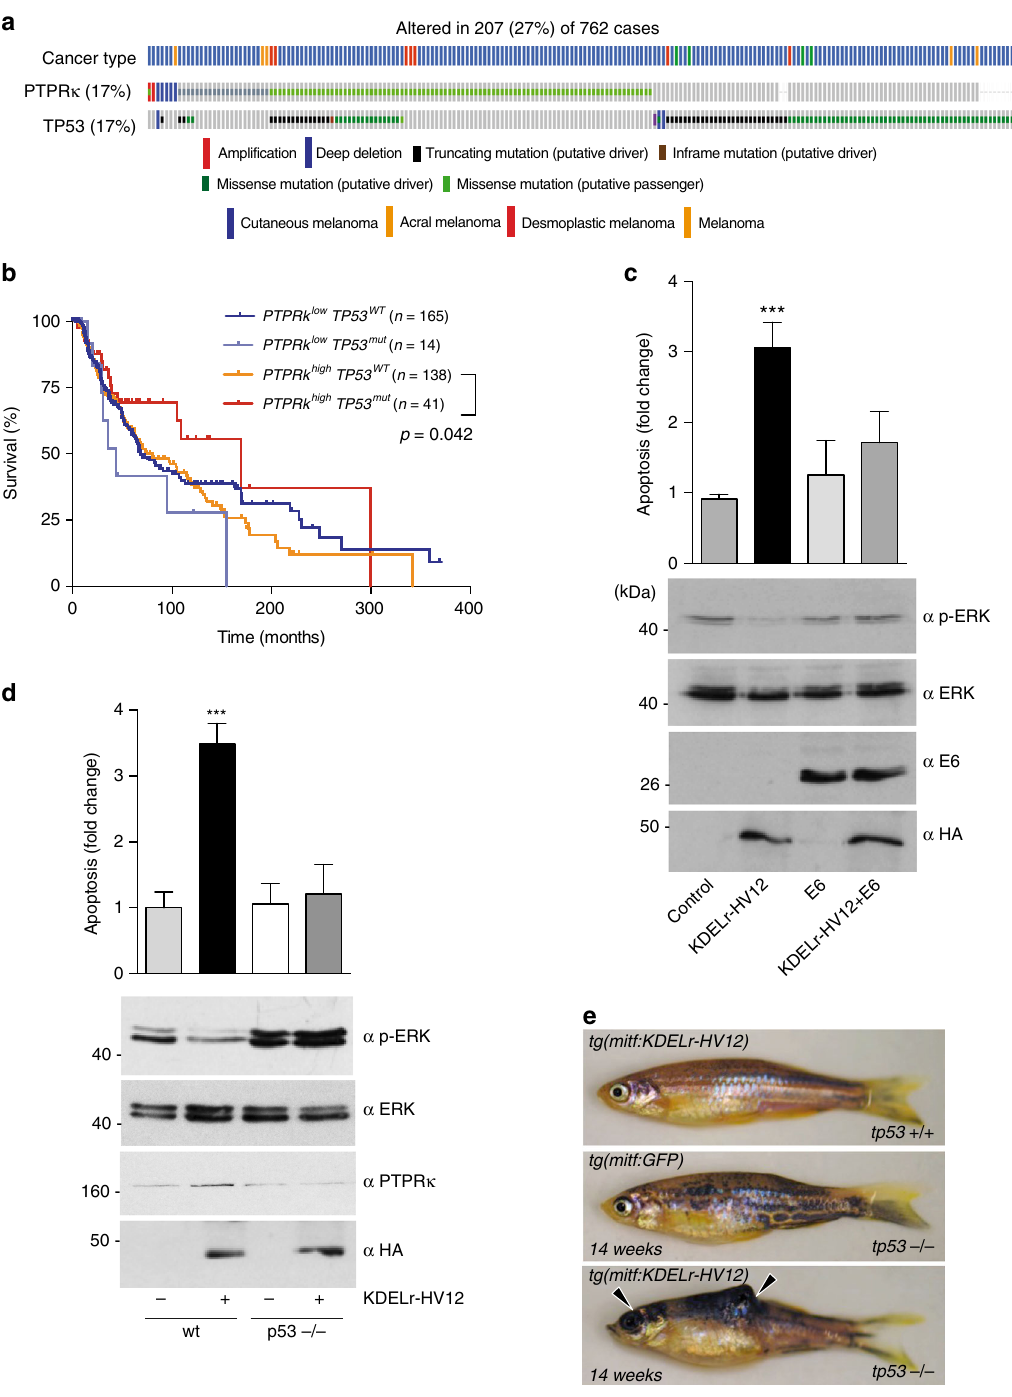
Fig. 10 TP53 status determines GC RAS-induced melanomagenesis. a Analysis of PTPR κ and TP53 mutational status generated using the TCGA dataset accessed through the cBioPortal for Cancer Genomics platform. b Survival curves for melanoma patients depending on PTPR κ expression levels and tp53 mutational status (obtained from TCGA melanoma dataset). c Effects of TP53 inactivation on ERK phosphorylation and apoptosis induced by GC RAS signals, as revealed in MCF-7 cells transfected with the indicated constructs. Data show average ± SEM from three independent experiments. *** p < 0.005 by Student's t -test. d Effects of TP53 status on ERK phosphorylation and apoptosis induced by GC RAS signals, as revealed in MEFs, wild-type (wt) and tp53-null,transfected with KDELr-HV12 (1 μ g) where shown ( + ). Data show average ± SEM from three independent experiments. *** p < 0.005 by Student's t -test. e tp53 inactivation is suf fi cient to promote melanomagenesis by GC RAS signals. Arrowheads show melanoma lesions in tp53 − / − zebra fi sh expressing the KDEL-HV12 transgene after 14 weeks. See also Supplementary Fig.